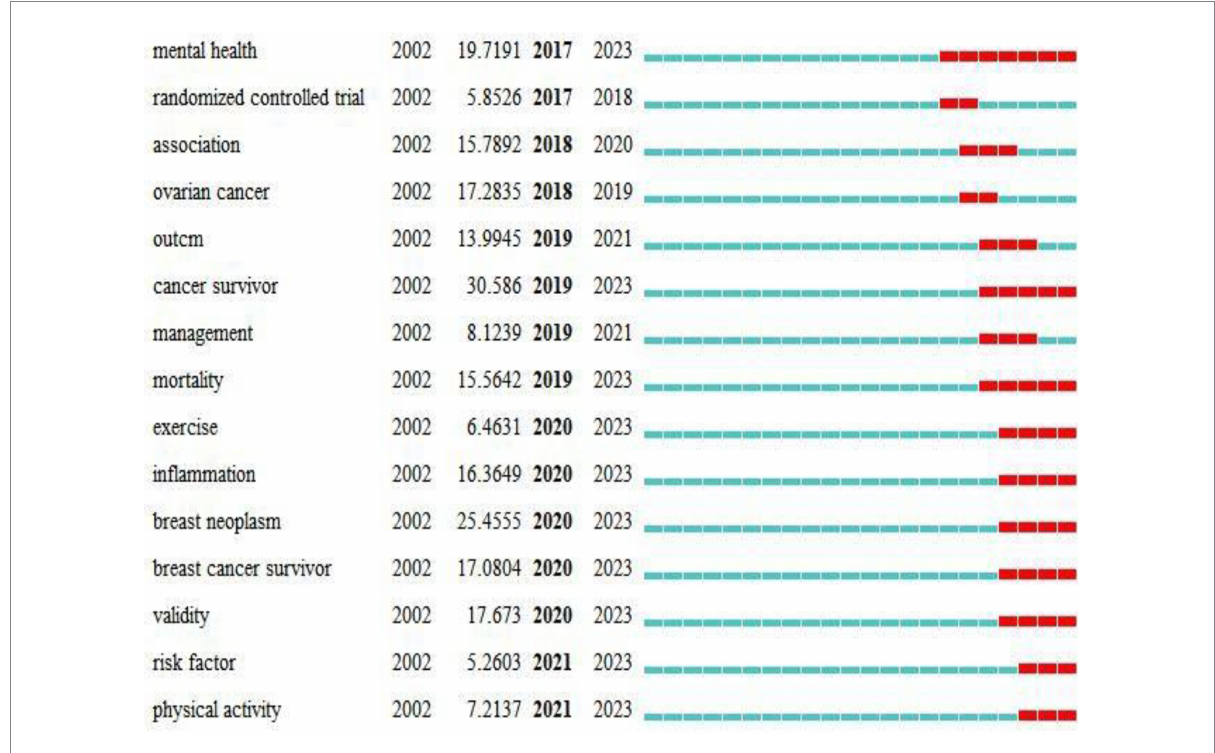
FIGURE 5 The evolution trend of depression in breast cancer from 2002 to